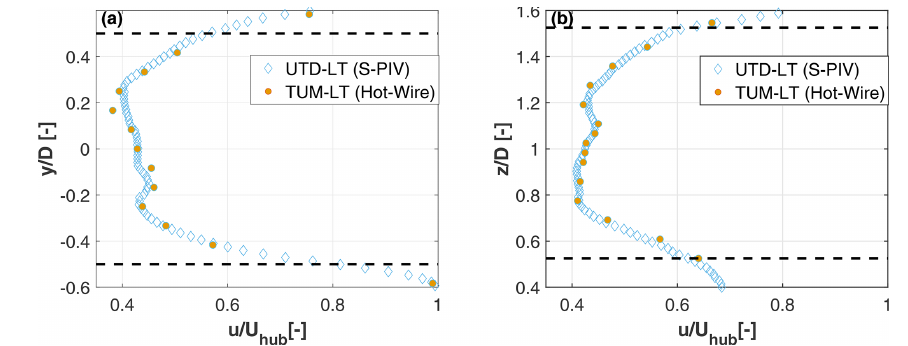
Figure 12. Comparison of wake measurements at x/D = 3 . 5 in two different wind tunnels and with two different measurement techniques. The comparison is made for laminar and uniform inflow (UTD-LT, TUM-LT). Black dashed lines indicate the rotor tips. Horizontal profile (a) ; vertical profile (b)